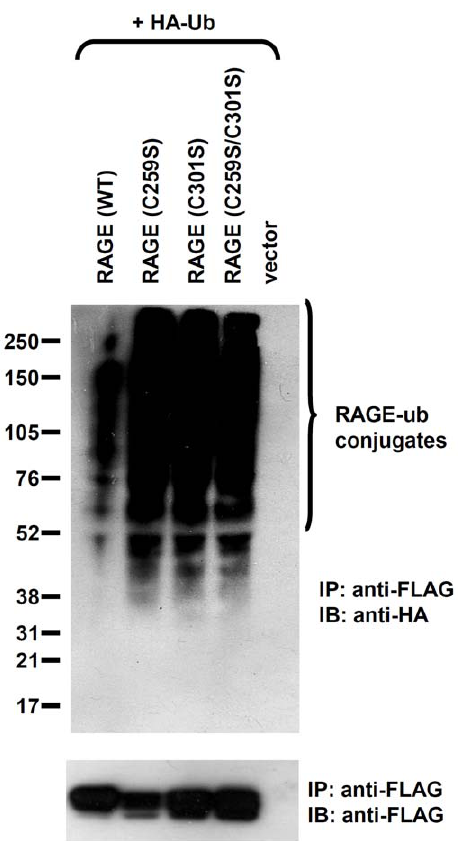
Figure 9. Unstable RAGE dimers are subjected to the ERAD pathway. Ubiquitination assays of RAGE (WT) and RAGE cysteine-to- serine mutants. CHO-CD14 cells were co-transfected with HA-ubiquitin and FLAG-RAGE/RAGE mutants. The transfected cells were then lysed and unfractionated membrane extracts were prepared. The lysates were IPed with anti-FLAG antibodies, and IBed with anti-HA (HRP conjugates) antibodies to demonstrate ubiquitination of RAGE mutants. Anti-FLAG (HRP conjugates) antibodies IB showed the expression of RAGE and RAGE mutants.